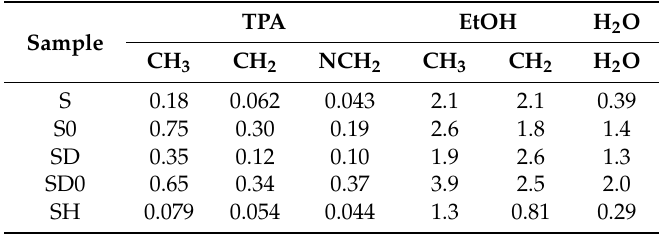
Table 3. Proton spin-lattice relaxation times (in s) 1 in the rotating frame ( T 1 ρ H ) of the resonances obtained for TPA, ethanol and water in the different